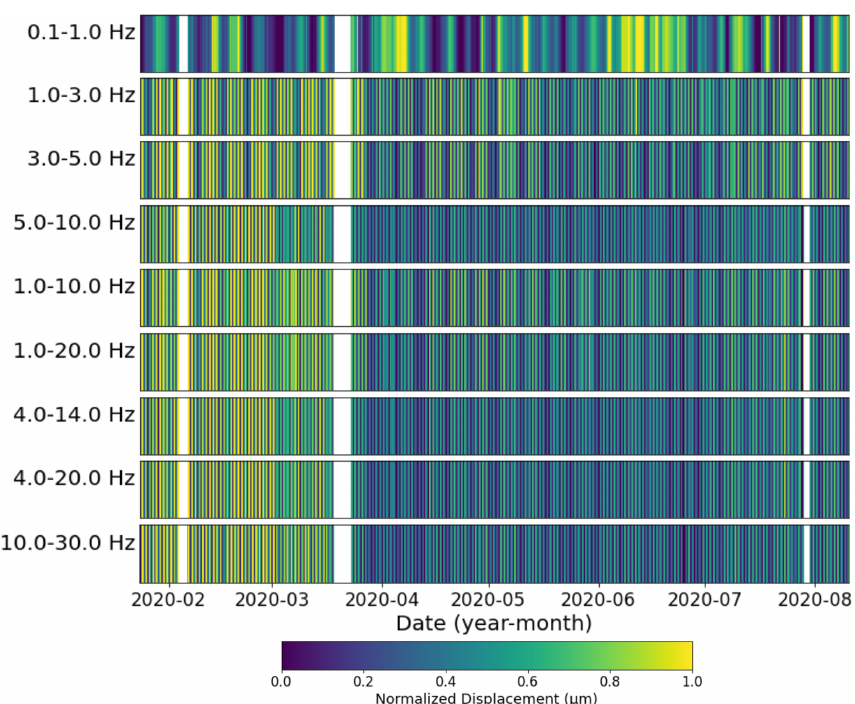
Figure 2. Normalized RMS amplitude at the vertical component of station MT18 in downtown Santiago. We tested nine bandpass filters between 0.1 to 30Hz (see y axis). White space corresponds to data